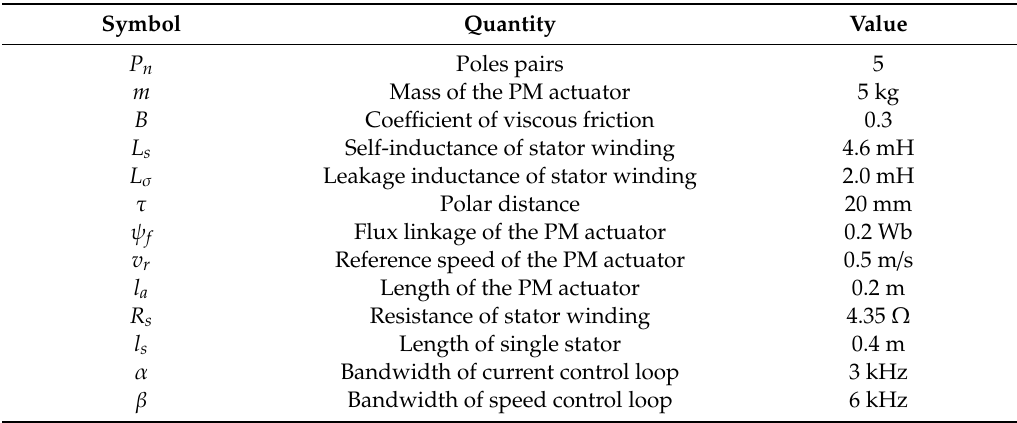
Table 1. Parameters of a segmented